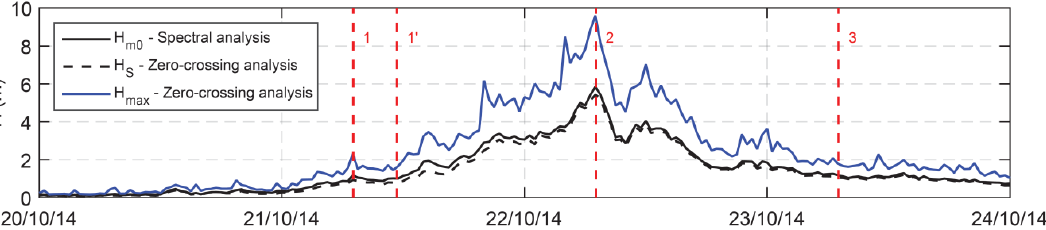
Figure 6. Significant wave height obtained from the heave by using zero crossing analysis (black dashed line) and frequency spectrum analysis (black line). The maximum wave height is reported as well (blue line). The vertical red dashed lines refer to the four points of interest along the route (as shown in Figure